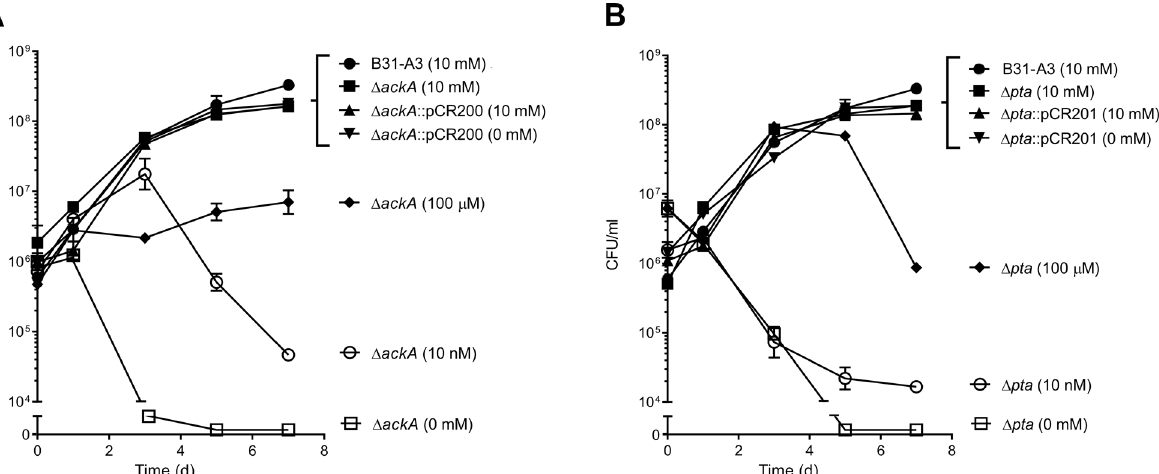
Fig 4. Growth and survival of B . burgdorferi B31-A3, Δ ackA , Δ pta , Δ ackA ::pCR200 and Δ pta ::pCR201 in the presence and absence of mevalonolactone. Growth of strains B31-A3, Δ ackA , and Δ ack ::pCR200 (A) and B31-A3, Δ pta , and Δ pta ::pCR201 (B) in BSKII supplemented with increasing concentrations of mevalonolactone (0 – 10 mM, shown in parentheses). Cells were quantified by culture in BSKII plating media supplemented with 10 mM